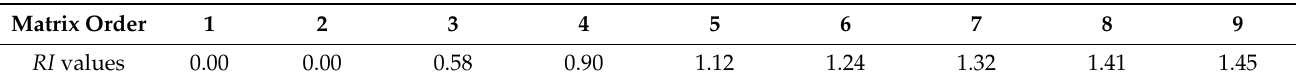
Table 2. Values of the RI